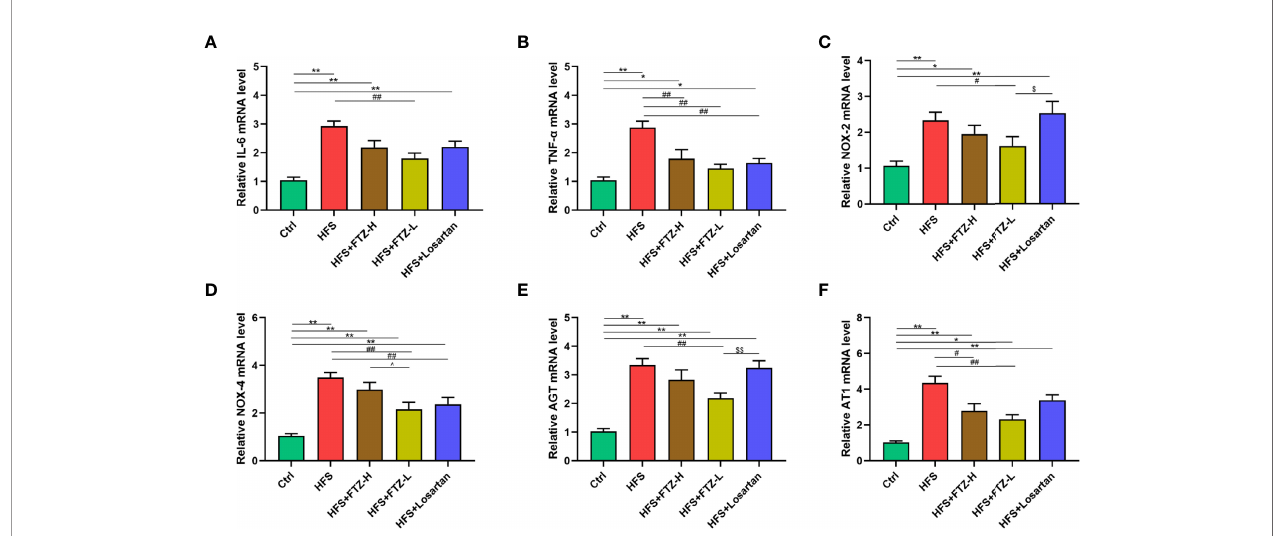
FIGURE 3 | FTZ alleviated renal gene expression of in fl ammation cytokines, NADPH oxidases, and RAS in HFS-fed rats. (A, B) Relative mRNA expression of IL-6 and TNF- a in renal cortex. (C, D) Relative mRNA expression of NOX-2 and NOX-4 in renal cortex. (E, F) Relative mRNA expression of AGT and AT1 in renal cortex. ∗ p < 0.05, ∗∗ p < 0.01 vs. Ctrl; # p < 0.05, ## p < 0.01 vs. HFS; ^ p < 0.05 vs. HFS+HFZ-H; $ p < 0.05, $$ p < 0.01 vs. HFS+losartan. n = 8 per group. FTZ, Fufang- Zhenzhu-Tiaozhi capsule; RAS, renin – angiotensin system; HFS, high fructose and high